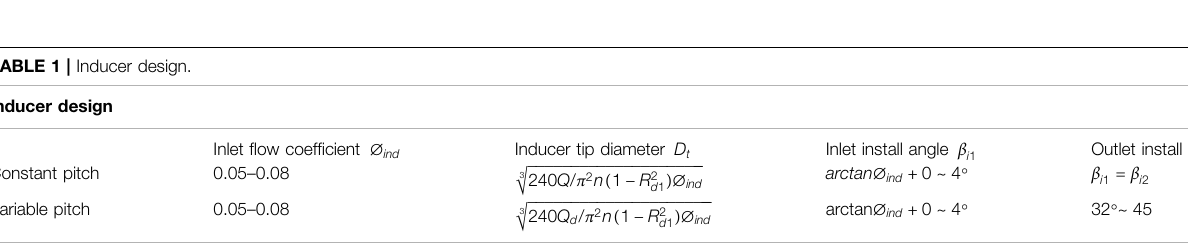
FIGURE 11 | Velocity streamline of the high-speed pump under four computational cases (Rong Xue, 2019).